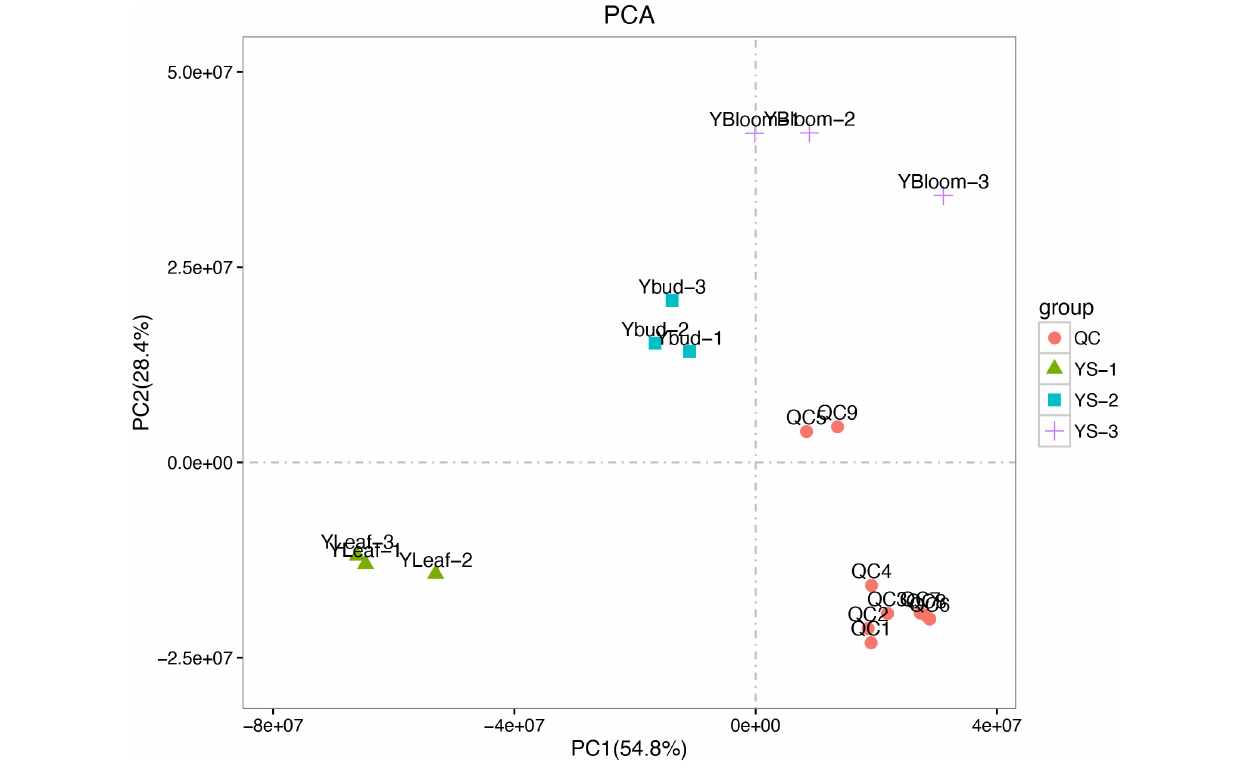
FIGURE 7 | Principal component analysis of test and quality control